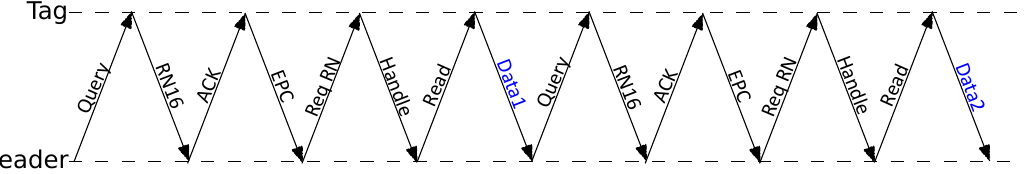
Figure 3. Example of the procedure followed by the standard protocol for N = 2 and S =